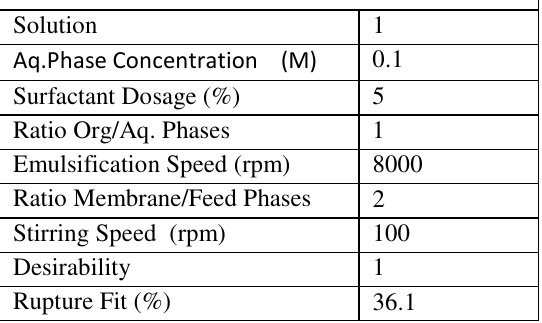
TABLE 5. SOLUTION FOR OBTAINING